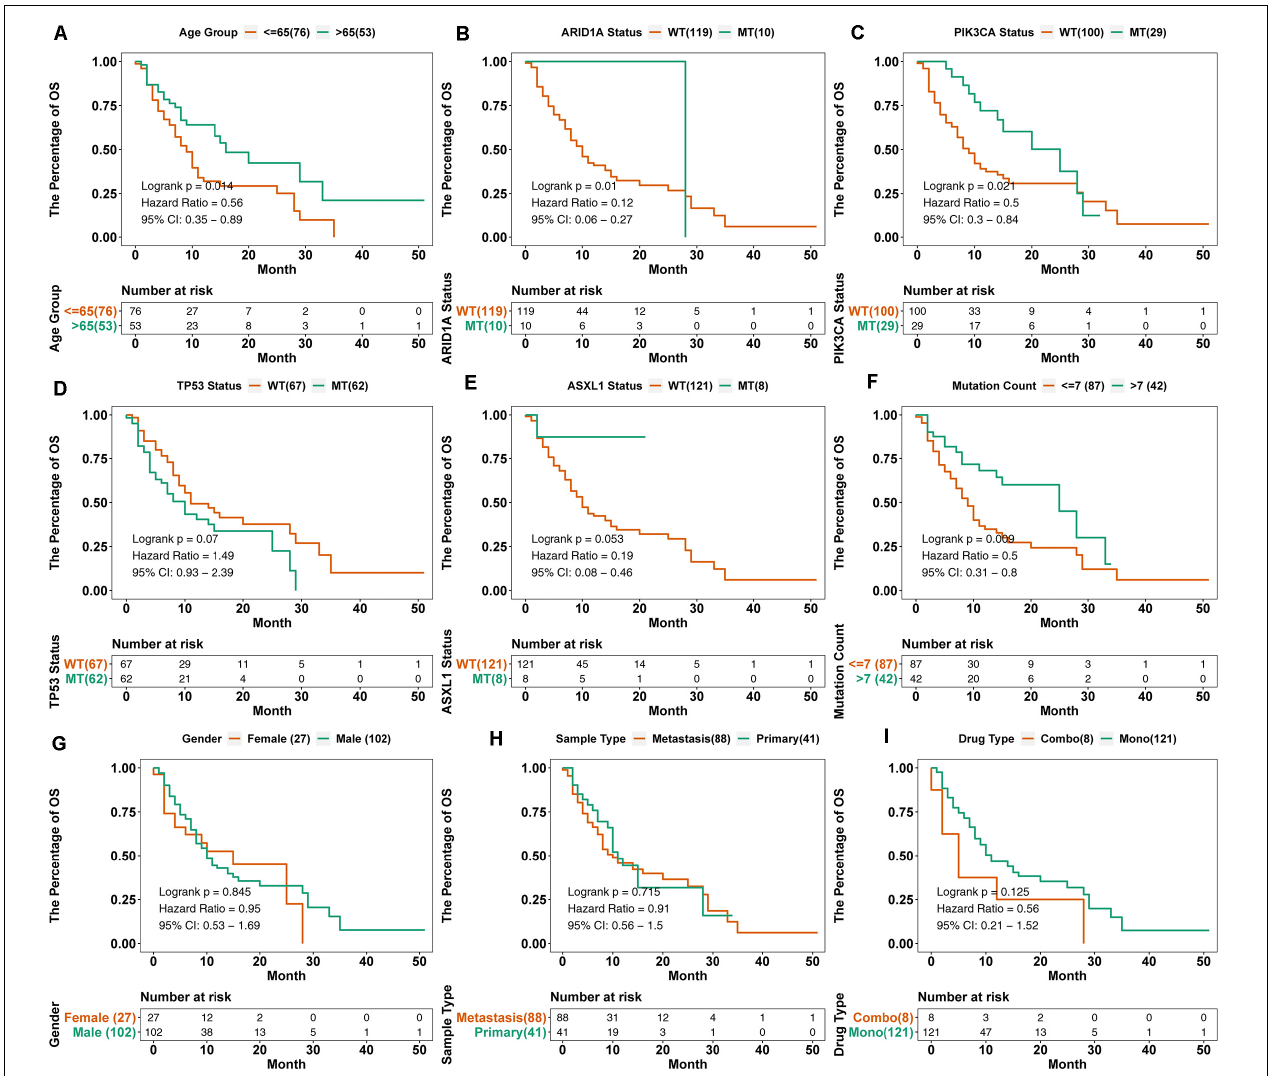
FIGURE 3 | KM survival curves for OS in 129 HNSC patients from the MSKCC cohort. We performed KM survival analysis on different subgroups of patients based on age (A) , gene mutation status (B–E) , mutation count (F) , sex (G) , sample type (H) , and drug type (I) . “Combo” represents the combination treatment of anti-PD-(L)1 and anti-CTLA-4 therapy, and “Mono” represents anti-PD-(L)-1